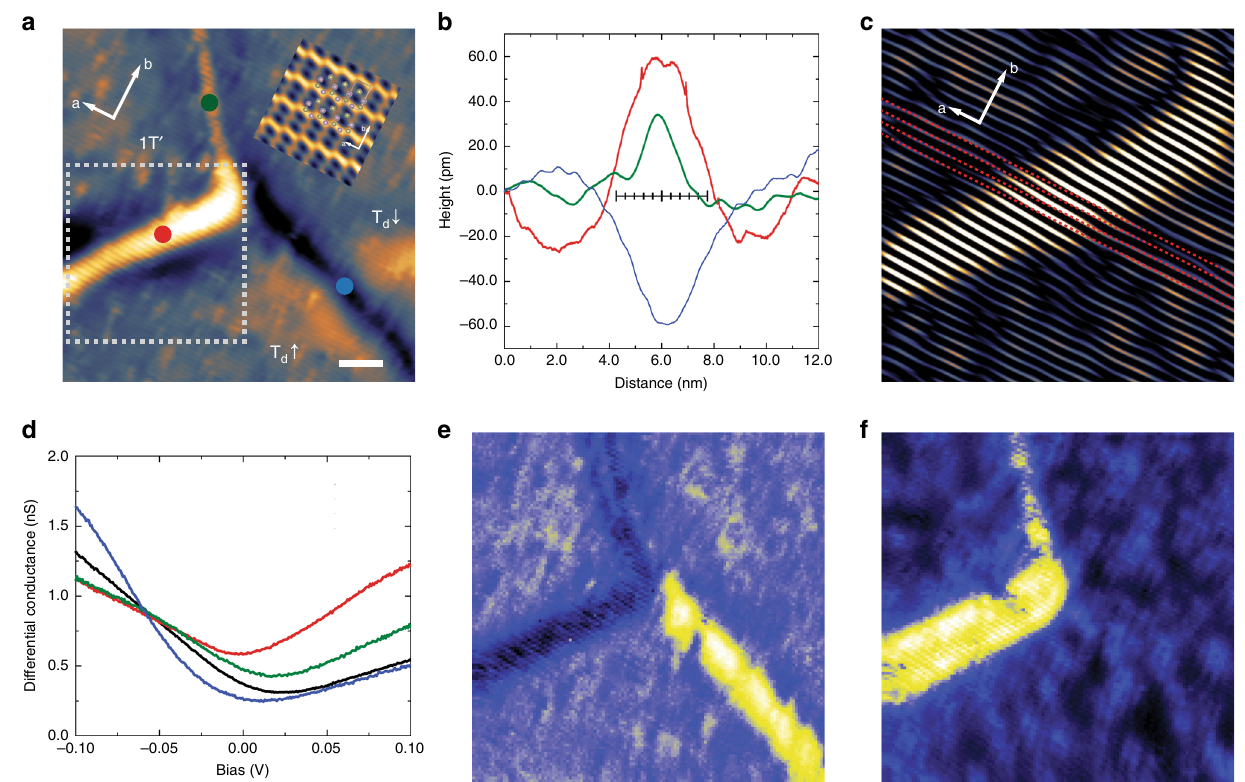
Fig. 5 (double columns) STM spectroscopic features of lateral phase domains and DWs in MoTe 2 :Fe at 77 K. a STM topography showing a junction of three domains and DWs. Inset: atomic resolution image of MoTe 2 showing Mo – Te – Mo chains. Scale bar: 5 nm. b Height pro fi le across each of three DWs obtained from red, green and blue dots in a . Red and green represent the fi rst-type protruded DWs and blue belongs to the second type. A ruler at the center shows the length of ten-unit cells for comparison. c Fourier fi ltered topography of the fi rst type DW from the dashed rectangle in a . Red dashed lines mark ideal chain directions and the topography on the protruded area reveals the deviation of chain from the ideal straight line. d Differential conductance obtained from each DW in a . Red and green curves: the fi rst-type protruded DWs; Blue curve: the second-type depressed DW; Black: the averaged curve obtained inside a domain, normalized at − 100 mV, 100 pA. e , f Spatial mapping of differential conductance at − 100 mV ( e ) and + 100 mV ( f ), normalized at − 50 mV, 100 MoTe 2 :Fe crystal with a slightly lower phase transition tem- perature (Supplementary Fig. 2). Consistent with the identical nature of each layer of 1T´ and T d phases discussed above, three